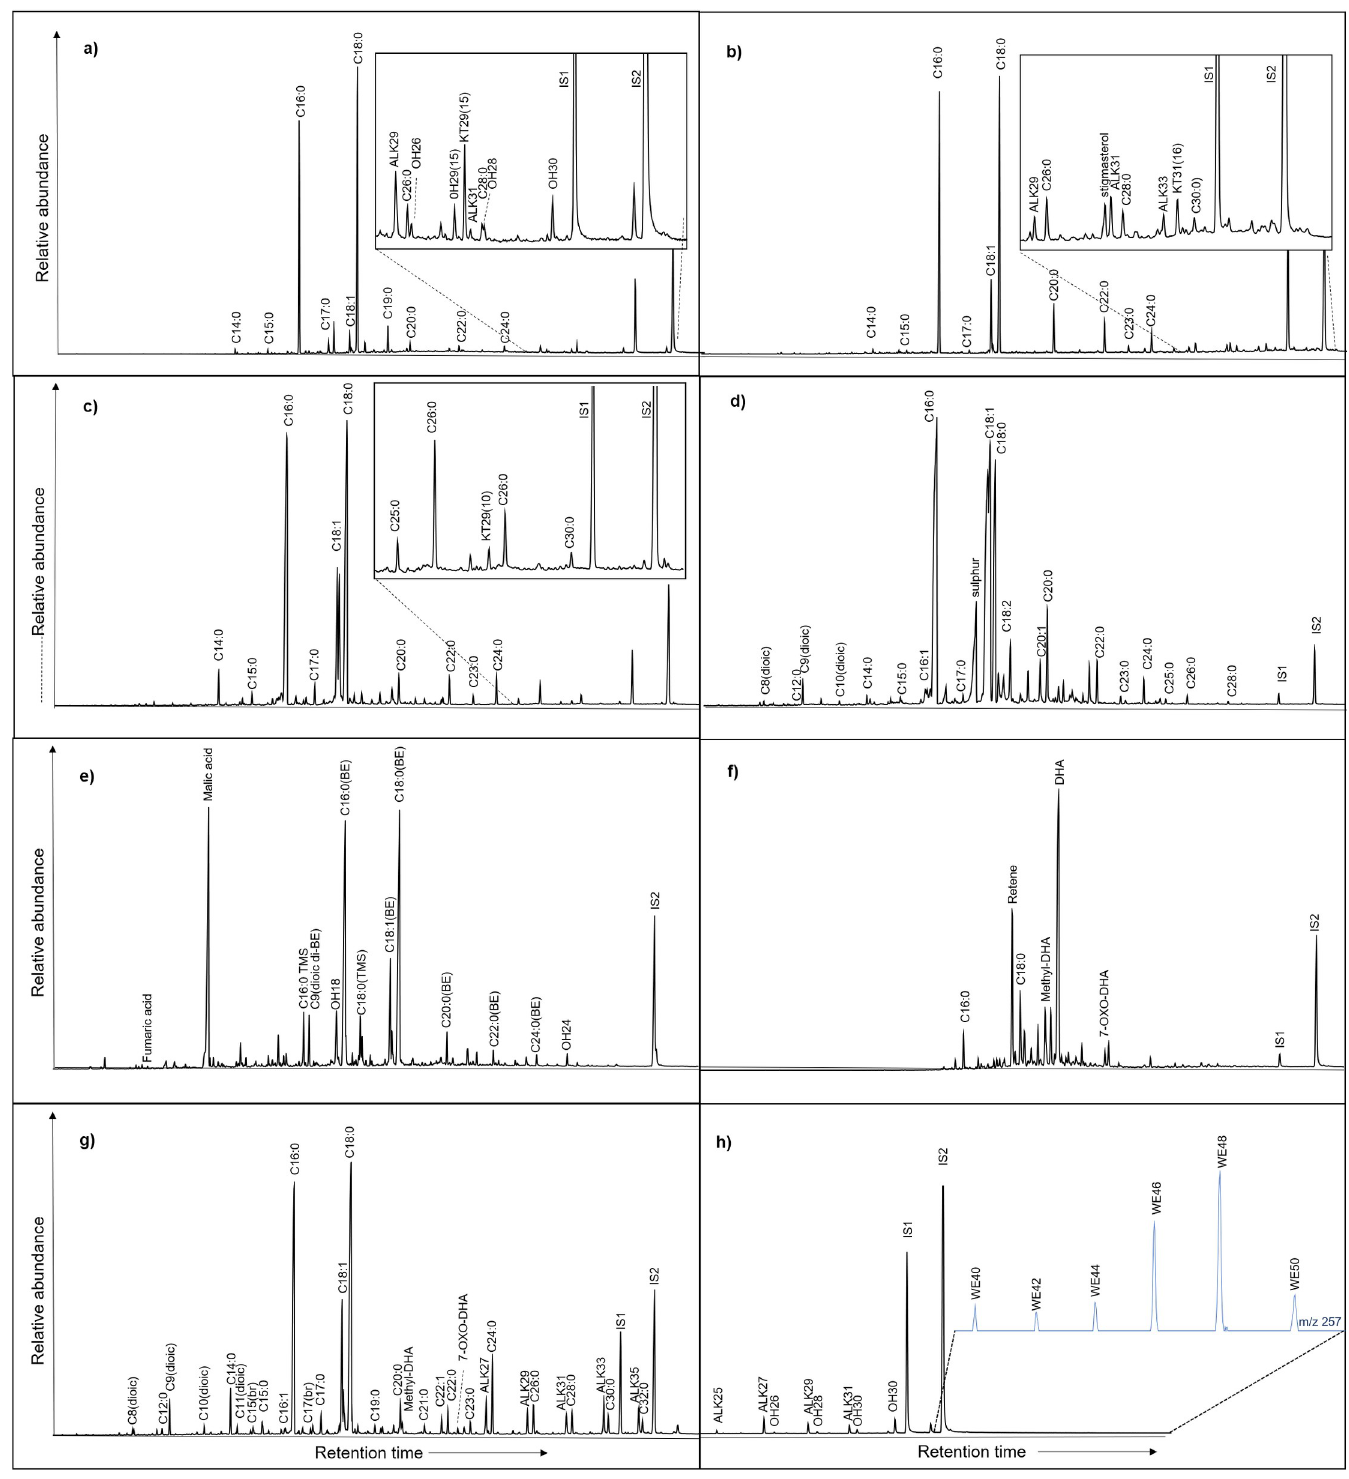
Fig 6. TIC chromatograms of extracts typical of a variety of products identified in these ceramics. a) AE chromatogram of sample GA_10 showing the presence of C 29(15) ketone that indicates the presumed presence of Brassica [9]. b) AE chromatogram of sample PB_26 showing the presence of C 31 ketone (hentriacontane-16-one) that indicates the presumed presence of leek ( Allium porrum ) in the ceramic samples [10–13]. c) AE chromatogram of CLESP_58 showing the presence of C 29(10) ketone (nonacosane-10-one) that indicates the presumed presence of ( Foeniculum vulgare ) (Fennel) [14]. d) AE chromatogram of CLESP_12 indicating plant oil by a C 18:1 /C 18:0